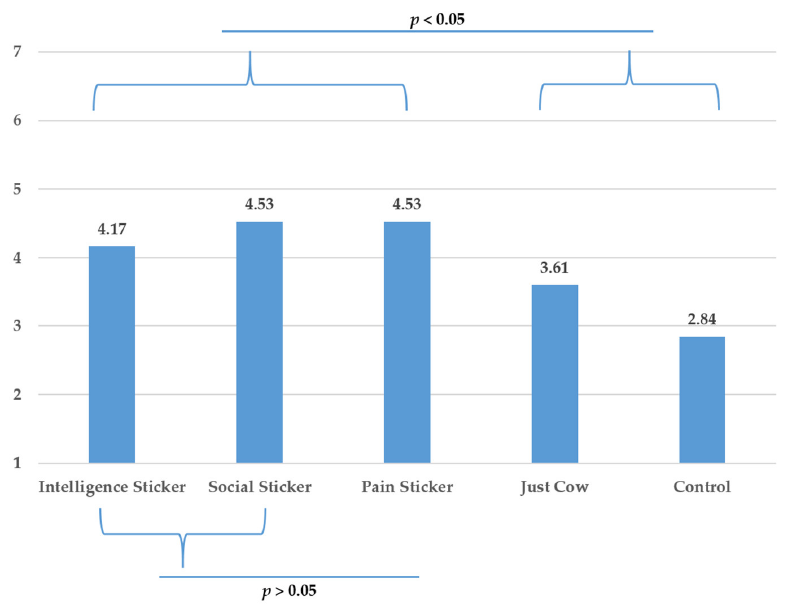
Figure 8. Intention to reduce meat consumption due to packaging: Means for the different conditions and results contrast analyses (Study 2).